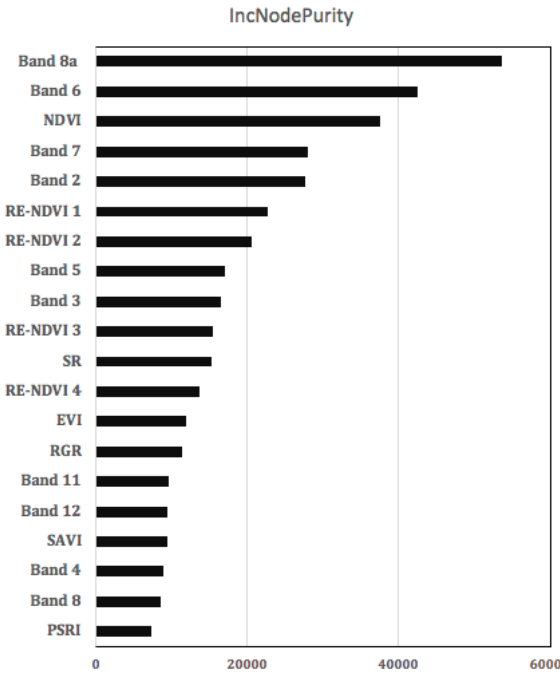
Figure 3. Relative importance of the variables